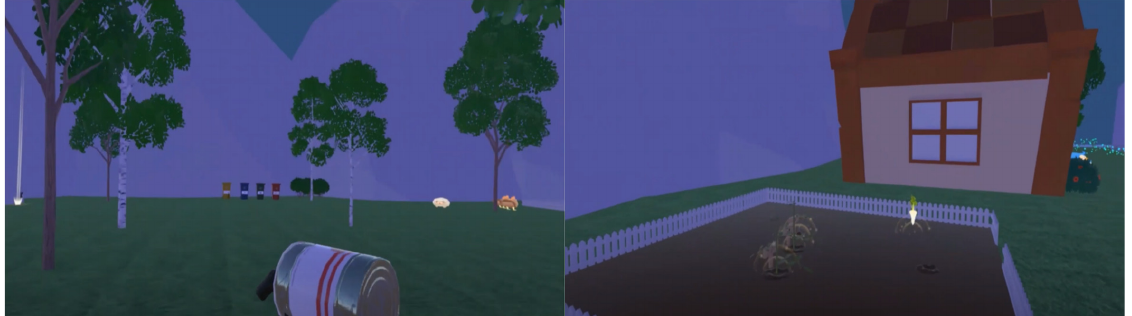
Figure 9. Separate waste collection for cleaning soil pollution (left), and garden in the village scene (right).